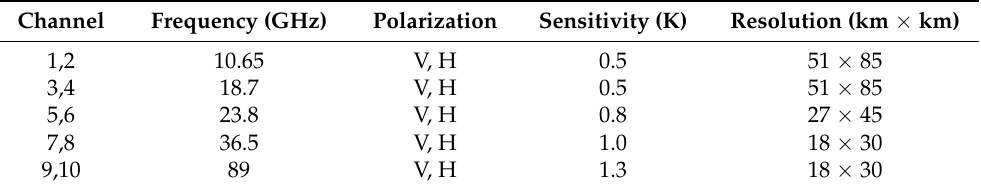
Table 1. Characterizations of the Fengyun-3B (FY-3B) satellite’s Microwave Radiation Imager (MWRI) channels.